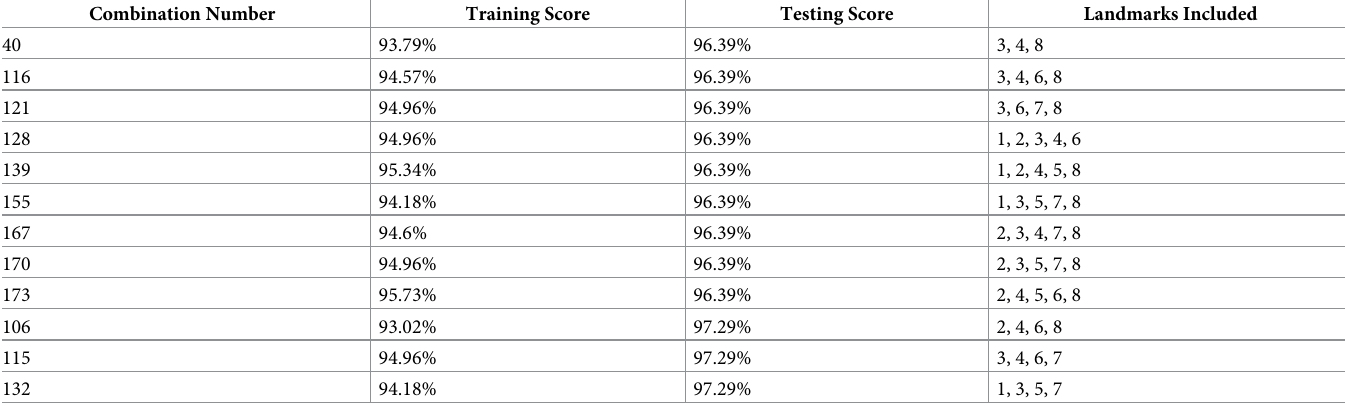
Table 4. The twelve landmark combinations which resulted in the highest testing scores, showing their corresponding training scores and which landmarks were included in each combination. Combination